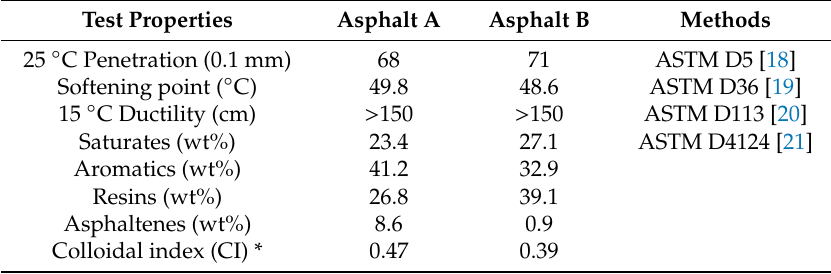
Table 1. Conventional properties and chemical compositions of base asphalt.